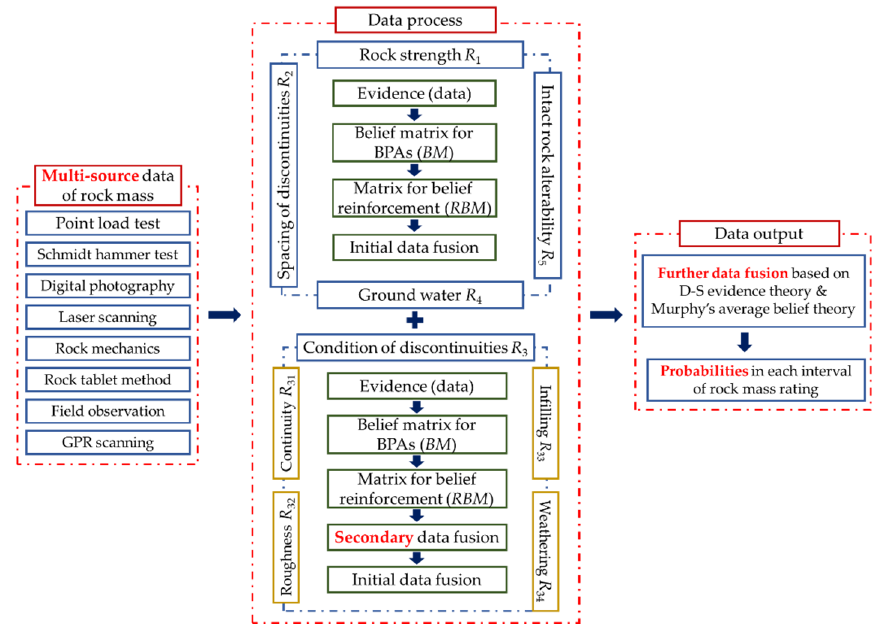
Figure 2. Flowchart of the proposed method.